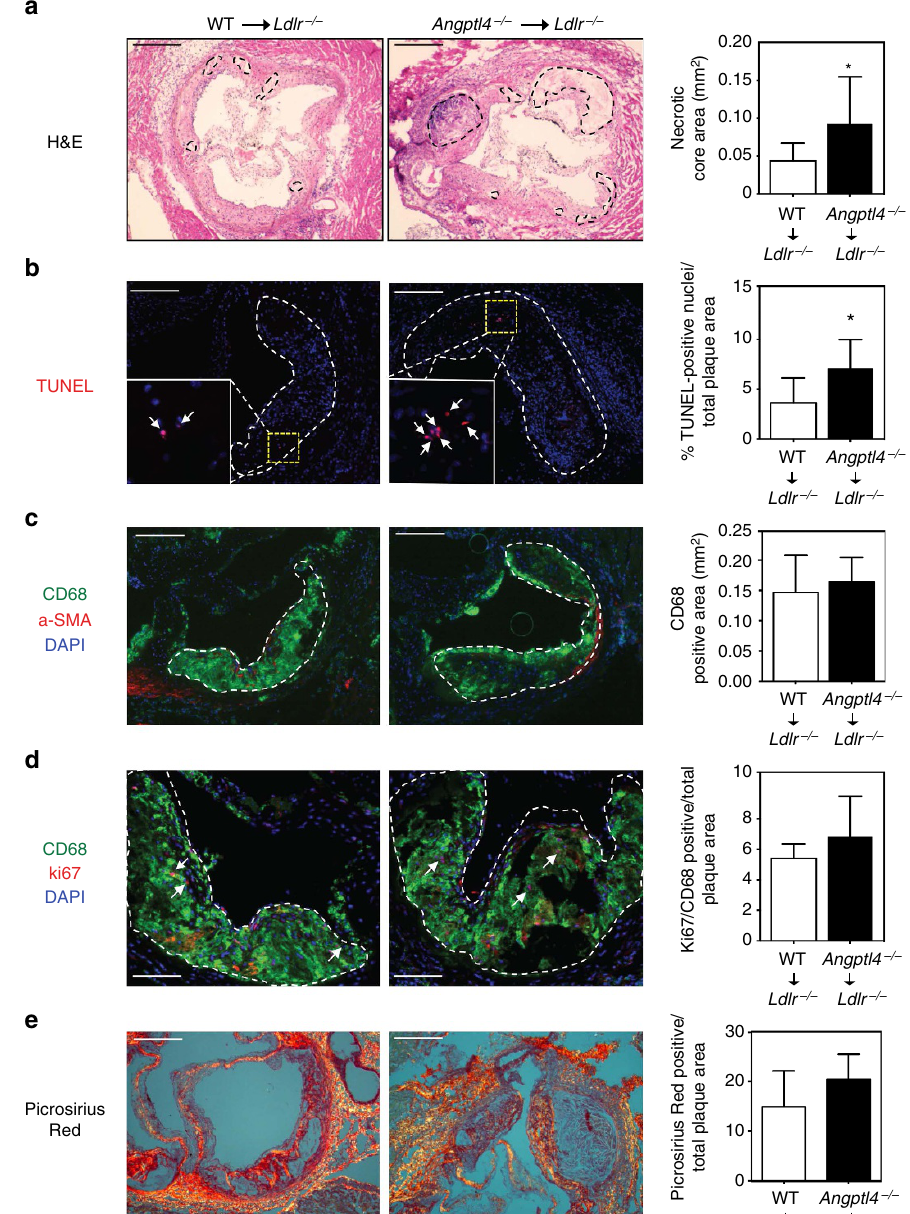
Figure 4 | Angptl4 (cid:2) / (cid:2) BM recipients have more apoptosis in the atherosclerotic lesions. ( a - d ) Representative histological analyses of the cross-sections of the aortic sinus from Ldlr (cid:2) / (cid:2) chimeras with WTor Angptl4 (cid:2) / (cid:2) BM after 12 weeks on WD stained with ( a ) H&E showing necrotic areas within dotted boundary (scale bars, 400 m m), ( b ) TUNEL; inset shows magnified TUNEL-positive area (scale bars, 200 m m), ( c ) CD68/ a -SMA/DAPI